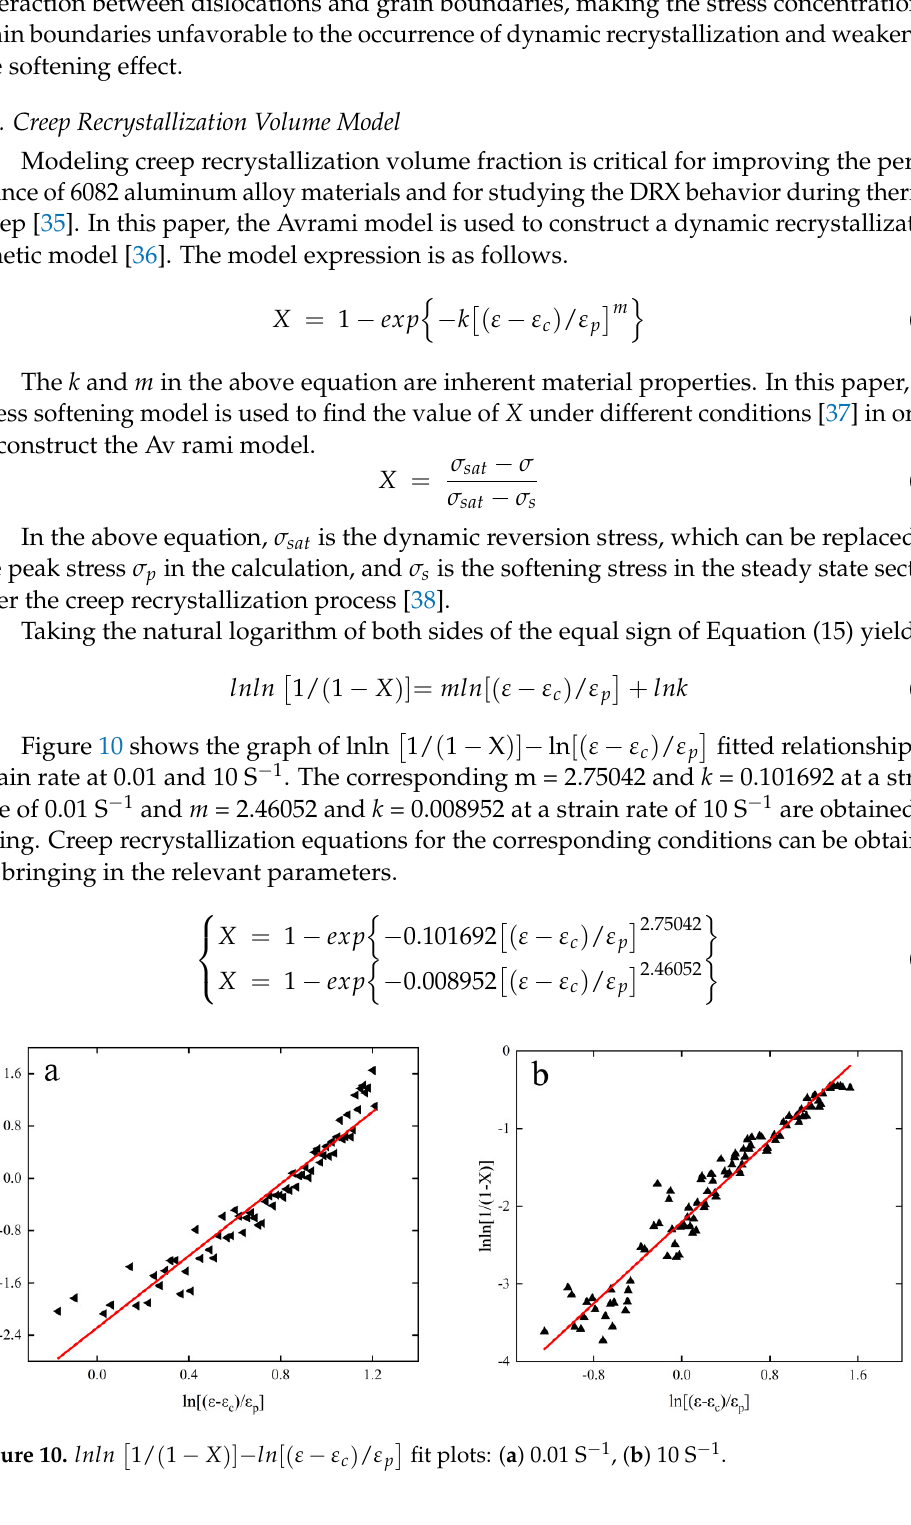
Figure 10.  [1/(1 − )] − [( −   )/  ] fit plots: ( a ) 0.01 S −1 , ( b ) 10 S −1. Figure 10. lnln (cid:2) 1/ ( 1 − X )] − ln [( ε − ε